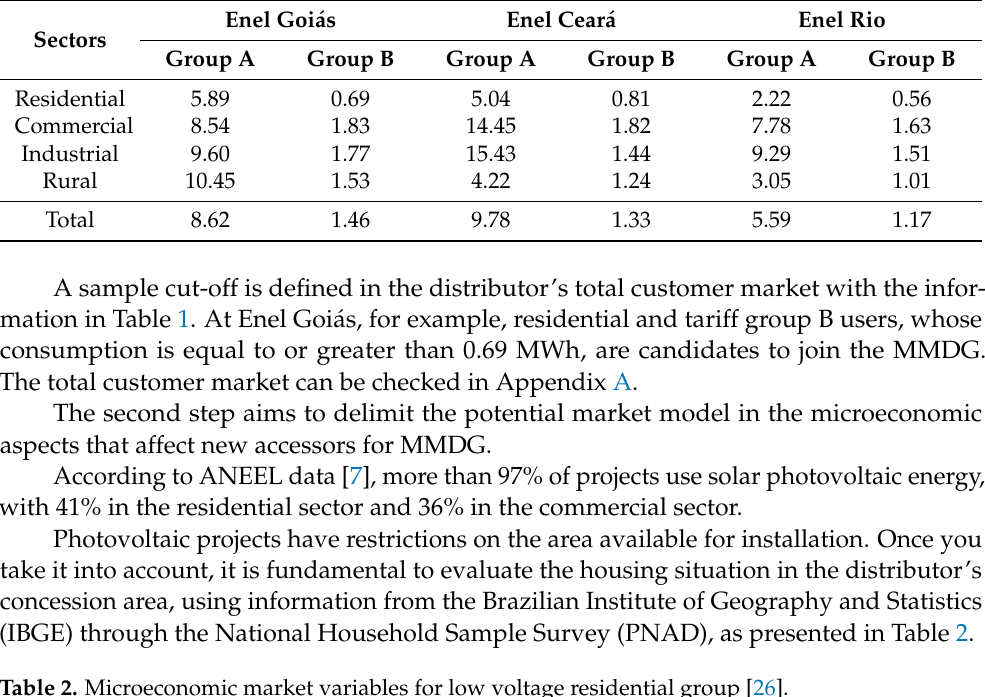
Table 2. Microeconomic market variables for low voltage residential group